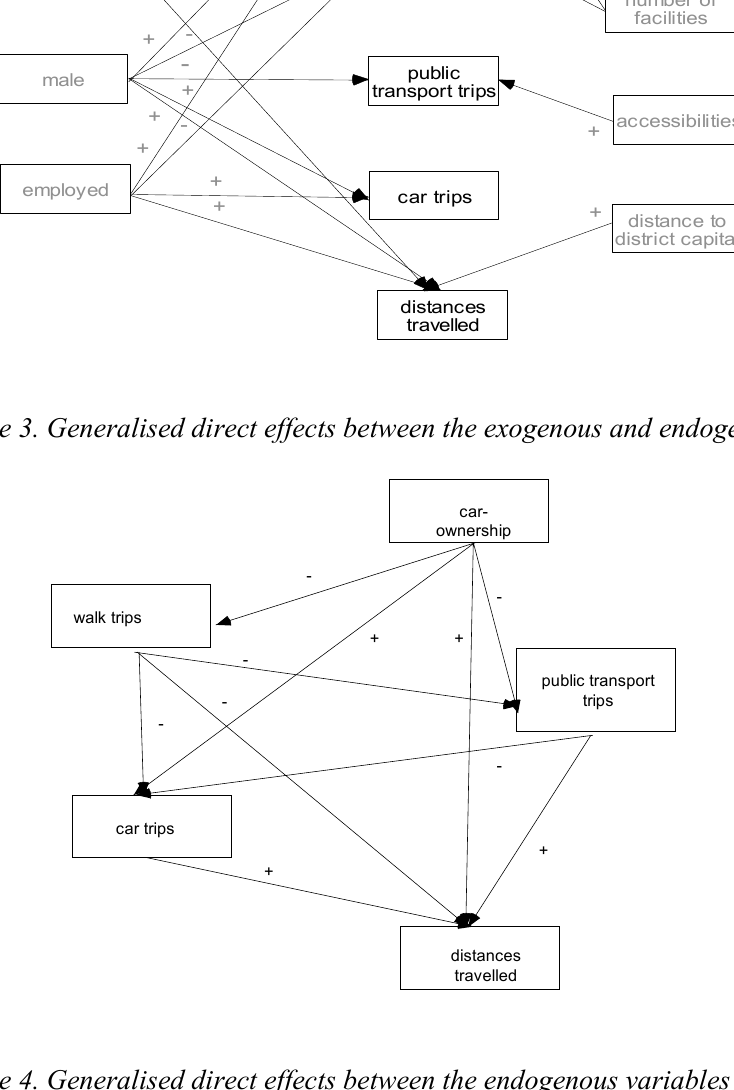
Figure 4. Generalised direct effects between the endogenous